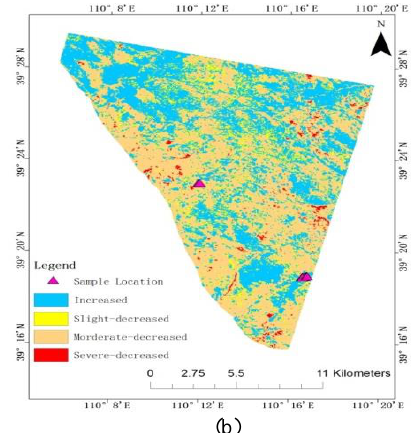
Figure 4. The changes of soil moisture from 2002 to 2009 (a) as well as from 2009 to 2015